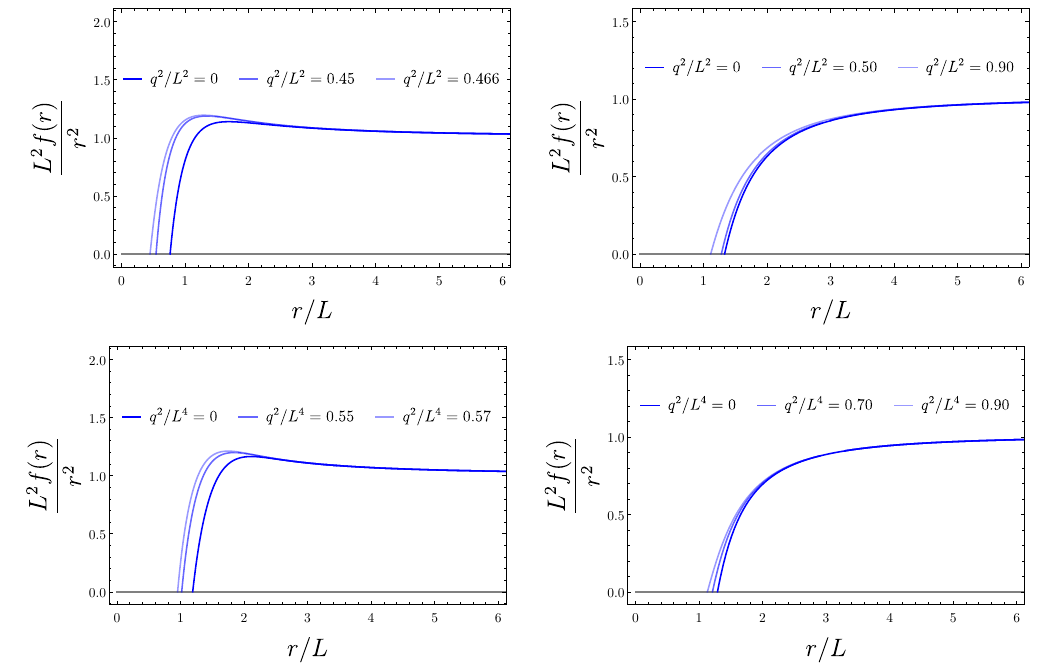
Figure 1 . Numerical solutions . Here we show numerical solutions for the metric function f ( r ) outside the black hole horizon for the cases: d = 4 with k = 1 (top left), d = 4 with k = 1 − (top right), d = 5 with k = 1 (bottom left), and d = 5 with k = 1 (bottom right). In the case − of four dimensions, we have chosen µ/L 4 = 1 / 50 and m/L = 1, while in five dimensions we set − 1 / 100 and m/L 2 = 1. In all cases, the value of the electric charge is indicated on the µ/L 4 = −